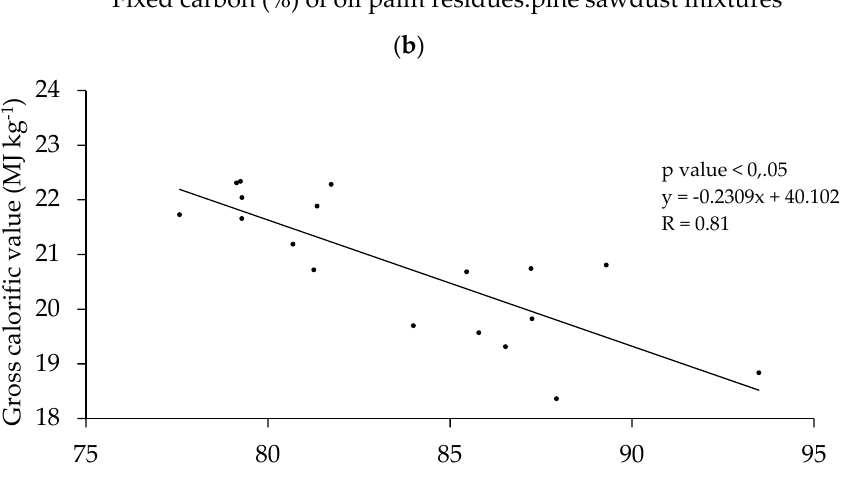
Figure 3. Relationship of gross calorific values of agro-pellets with ( a ) mixing ratios of oil palm residues:pine sawdust; ( b ) fixed carbon of oil palm residues:pine sawdust mixtures, and ( c ) volatile matter of oil palm residues:pine sawdust